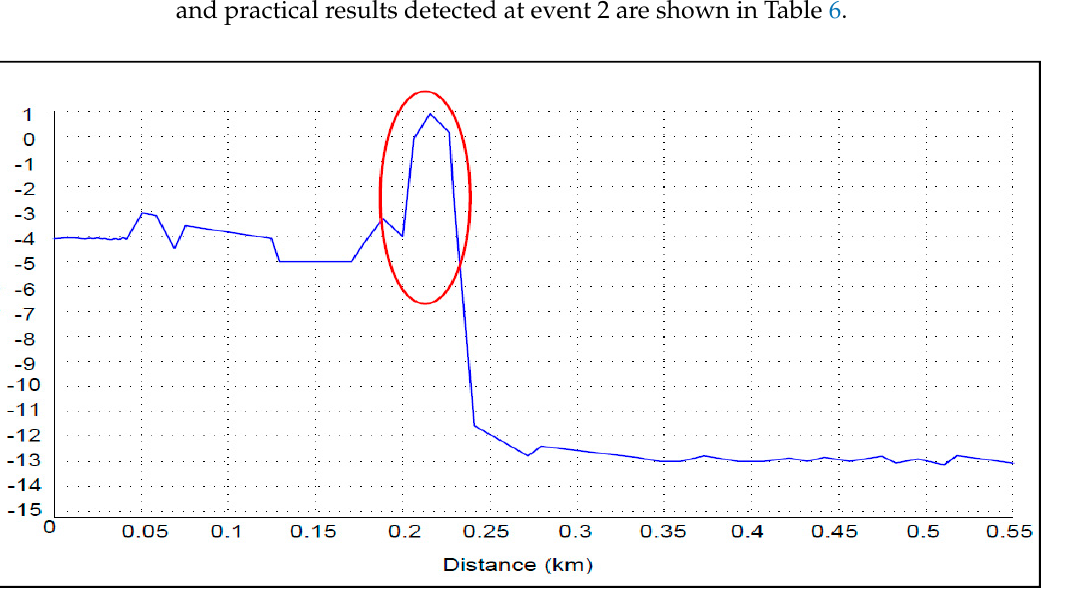
Figure 7. The improving FPMT circuit detected a fiber break pattern shape in event 1.